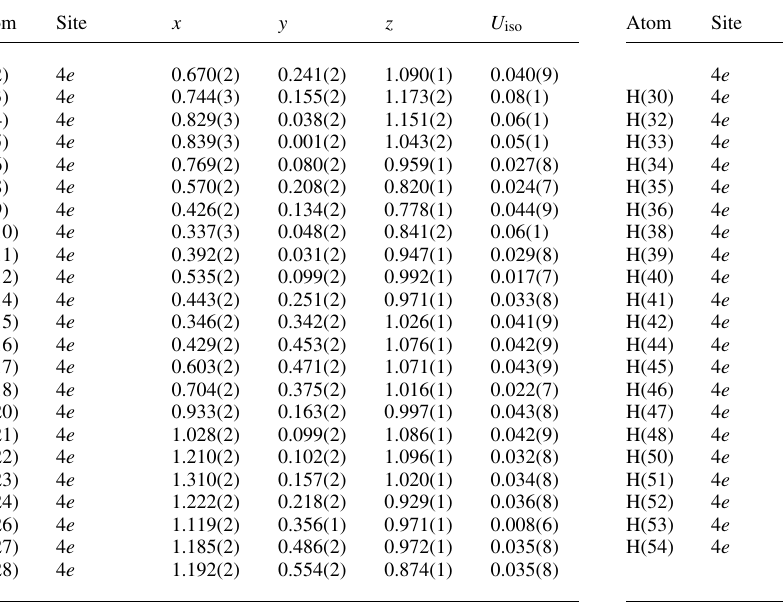
Table 2. Atomic coordinates and displacement parameters (in Å 2 )